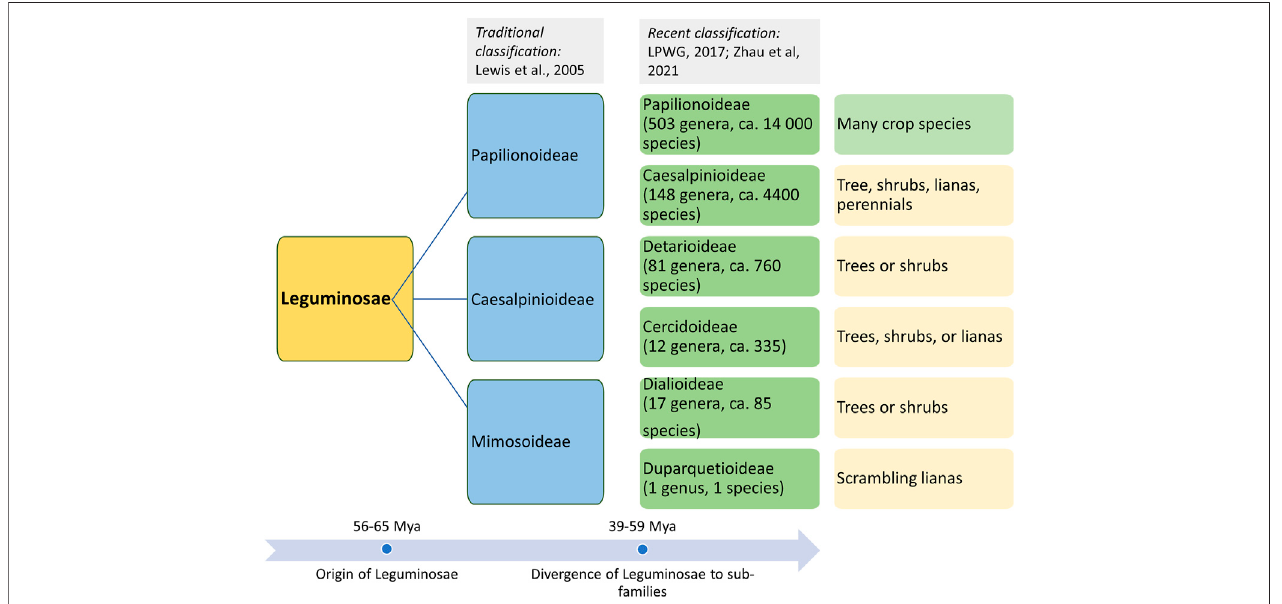
FIGURE 1 | Origin of the Leguminosae family and classi fi cation of its members in three major subfamilies (traditional classi fi cation) and six subfamilies based on recent phylogenetic studies.